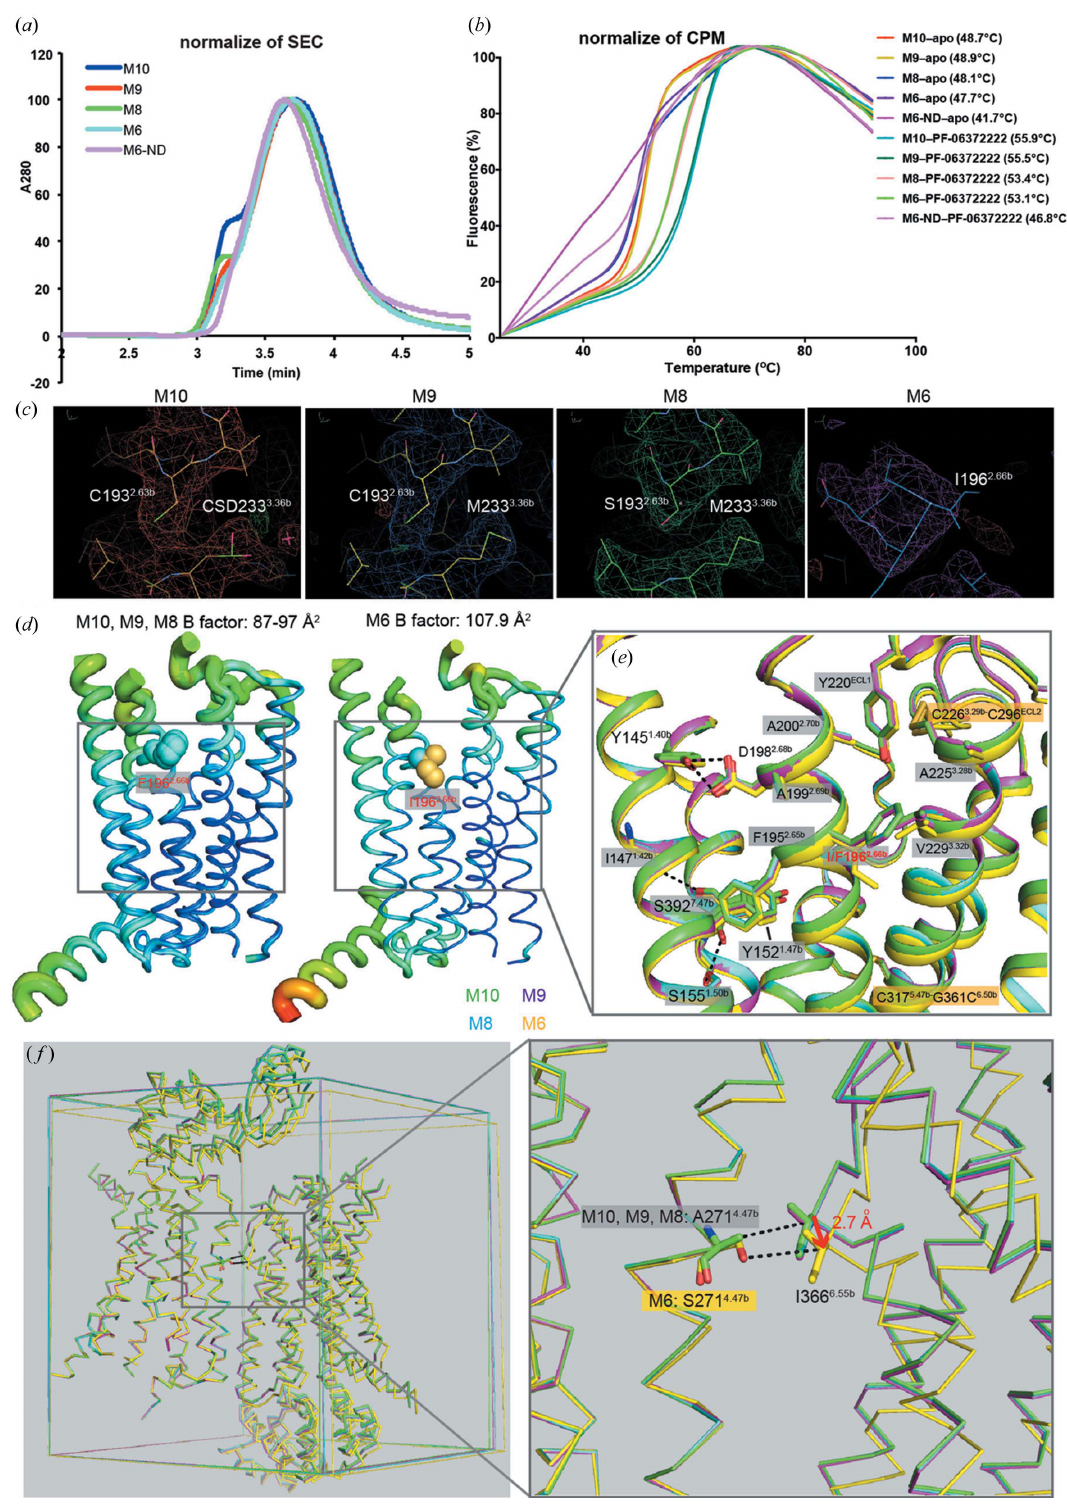
Figure 2 Thermal-shift assay of GLP-1R mutants, and potential mechanisms of I196 2.66b Fand S271 4.47b A in the thermal stability and crystallization of GLP-1R. ( a ) SEC of GLP-1R fusion proteins suggests that the GLP-1R mutants are mostly monomeric and of similar homogeneity. ( b ) Thermal-shift assay of GLP- 1R mutants in apo state or in complex with ligand PF-06372222. The different melting temperatures of the GLP-1R mutants indicating these mutations significantly affect thermal stability. ( c ) Densities of representative mutations in mutant structures. ( d ) B factor and distribution map of four constructs. ( e ) I196 2.66b F mutation stabilized GLP-1R through its connections with the central polar network and other regions. ( f ) Packing and asymmetric unit of the four crystallized constructs. The back mutation of A271 4.47b S induced significant change in the cell contents of M6 (yellow) compared with the other three back mutations and disturbed the packing. The four structures are superimposed through chain b. In Figs. 2( e ) and 2( f ) the color codes are shown in the key at the